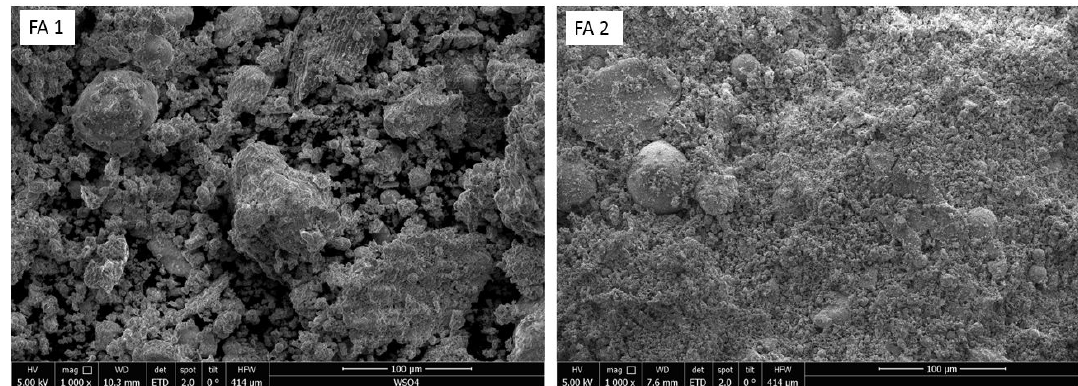
Figure 3. Scanning electron microscopy (SEM) photographs of fly ash samples at 1000× magnification.